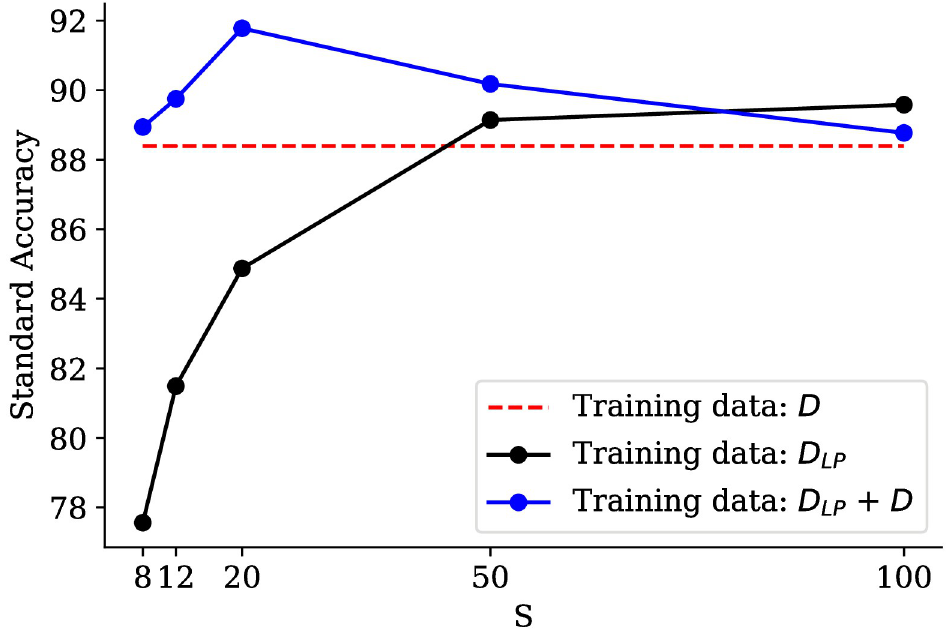
Fig 9. Comparison of standard accuracy with three different training data on PointNet model. Three approaches are tested on ModelNet40 test data. Numbers on horizontal axis indicate the degree of low pass versions with different S